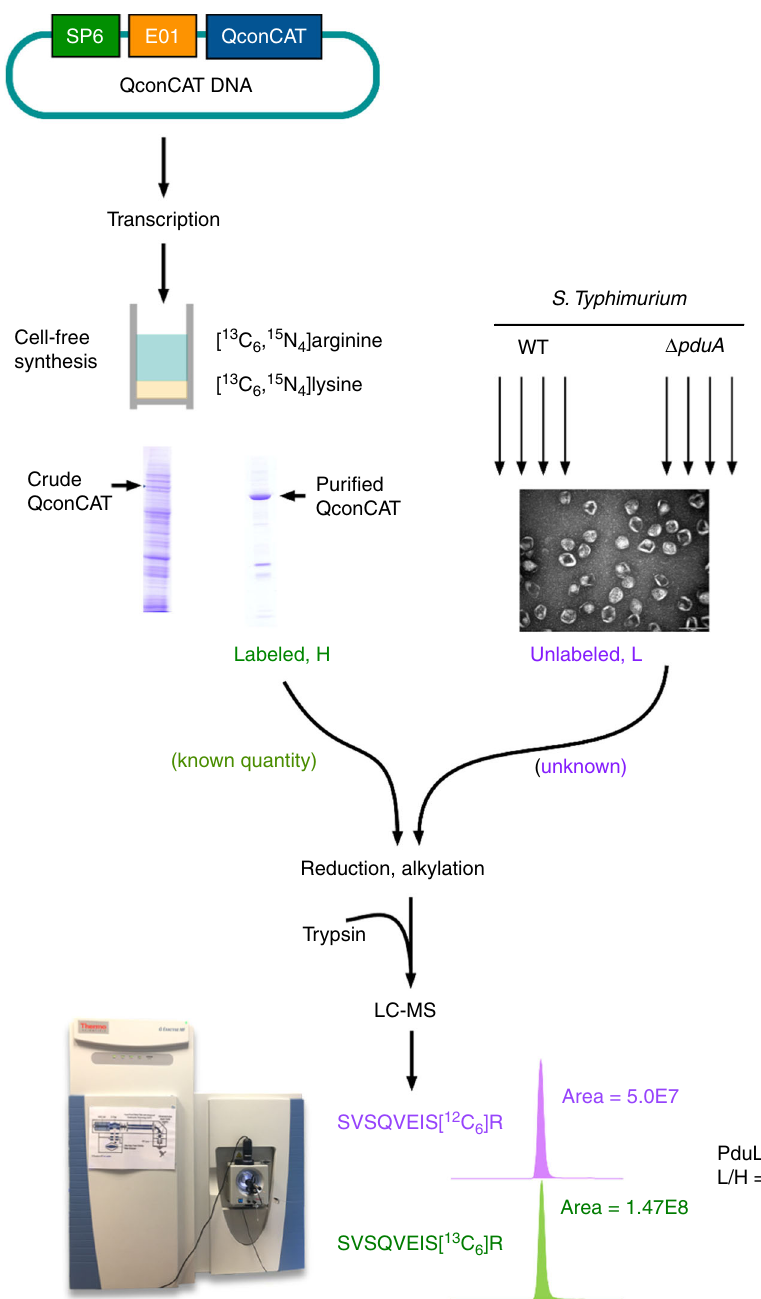
Fig. 2 Schematic overview of QconCAT strategy. The QconCAT gene was subcloned into a plasmid vector (pEU01) optimised for cell-free system (CFS). The CFS was employed for transcription and translation to express the QconCAT proteins labelled with stable isotopes ([ 13 C 6 , 15 N 4 ]arginine and [ 13 C 6 , 15 N 2 ]lysine). The labelled QconCAT proteins (heavy, purple) were puri fi ed, quanti fi ed, and added to isolated Pdu MCPs from WT or Δ pduA cells with four replicated (unlabelled, light, green) in known quantity. After trypsin digestion, analyte mix released each of the QconCAT peptides in a strict stoichiometry of 1:1. LC-MS analysis allowed the quanti fi cation of each represented peptide of the isolated Pdu MCPs. One signature peptide for PduL, SVSQVEIS, was shown as an